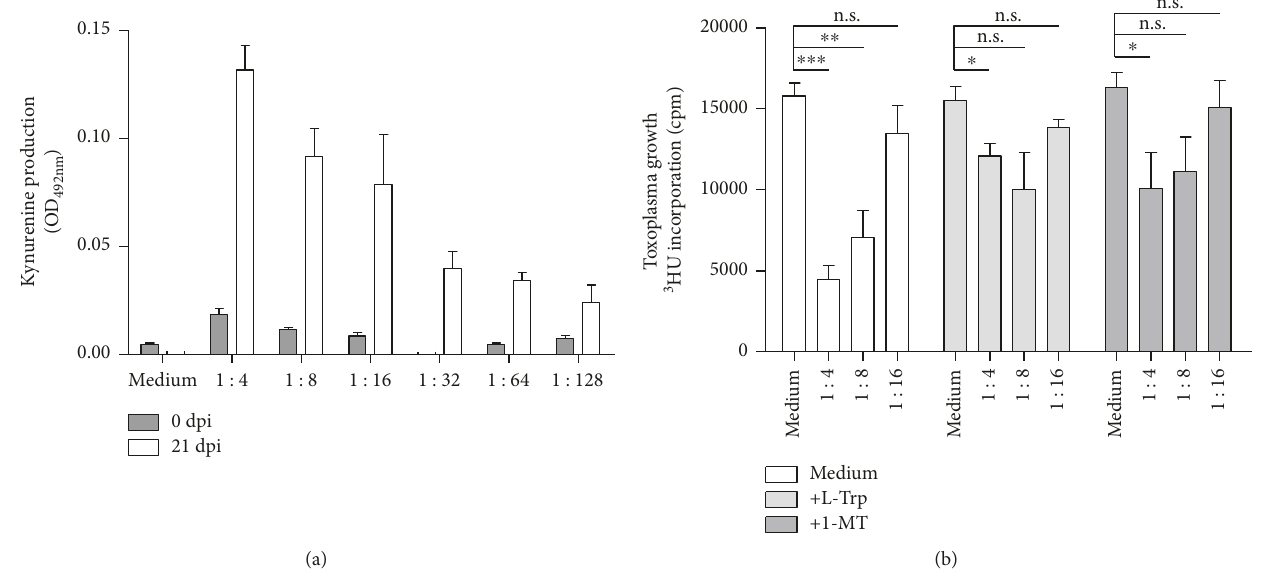
Figure 6: Supernatants of TLA-stimulated PBMC obtained from T. gondii -infected animals induce IDO activity and antiparasitic e ff ects in porcine PCP-R cells. 3 × 10 5 PCP-R cells were stimulated with serially diluted supernatants from TLA-activated porcine PBMC. (a) After three days of PBMC culture, supernatants were harvested and the kynurenine concentration was determined using Ehrlich ’ s reagent. (b) Identical cell cultures were infected with T. gondii (3 × 10 4 ME49 tachyzoites per well) after stimulation with T cell supernatants. In some cultures, L-tryptophan (100 μ g/ml) or 1 MT (100 μ g/ml) was added. After three days, toxoplasma growth was monitored using 3 H-uracil incorporation. Data are given as mean ± SD of triplicate cultures; signi fi cant di ff erences were marked with asterisks (n.s. =not signi fi cant; ∗ p ≤ 0 05 , ∗∗ p ≤ 0 01 , and ∗∗∗ p ≤ 0 0001